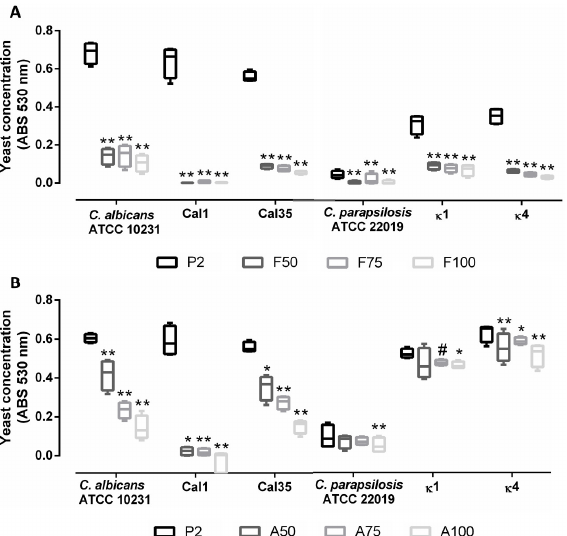
Figure 4. Quantification of non-adherent planktonic yeasts following incubation of titanium pieces coated with P2 (control), fluconazole-loaded coatings ( A ) or anidulafungin-loaded coatings ( B ). Data are represented as median and interquartile range of absorbances (absorbance units, AU) obtained in at least three independent experiments. *: 0.05 > p > 0.01; **: p < 0.01, #: 0.051 > p > 0.099 for Wilcoxon test between the control coating (P2) and the other coatings. When evaluating the prevention of biofilm formation, antifungal loading showed a concentration-dependent effect: coatings loaded with maximum concentrations of fluconazole (F100) or anidulafungin (A100) caused the greatest inhibition in biofilm development in both species, inhibiting both species by up to 60% (Figure 5). Moreover, loading with anidulafungin prevented